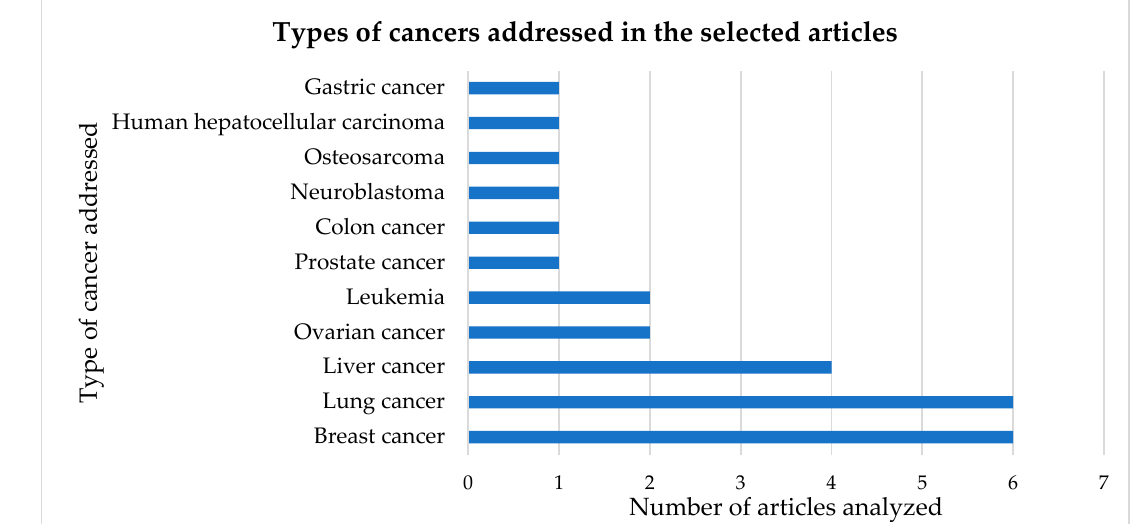
Figure 2. Number of articles for the different types of cancers studied.